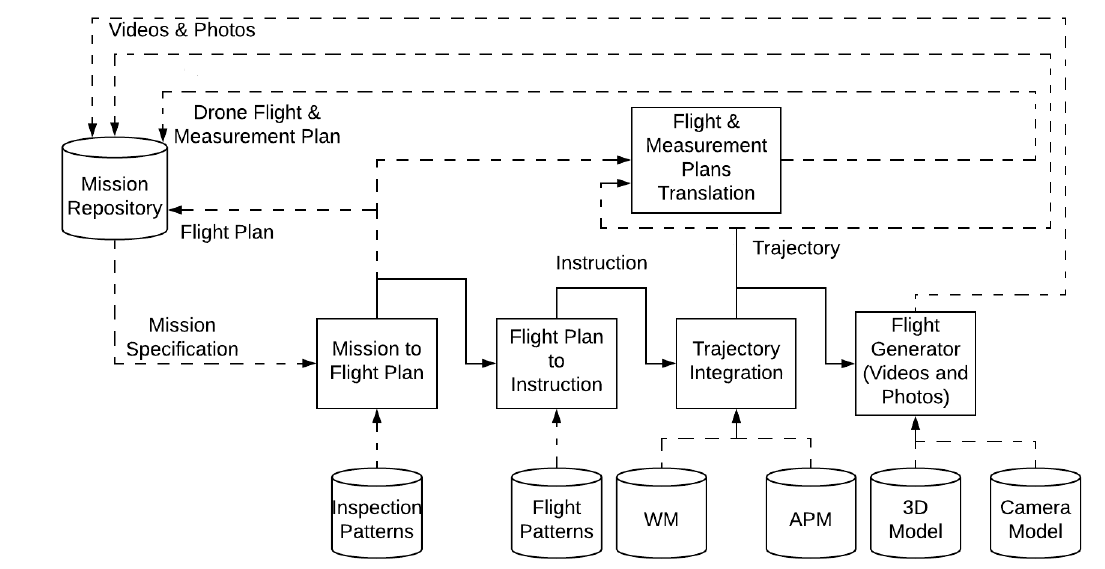
Figure 3. Architecture Mission